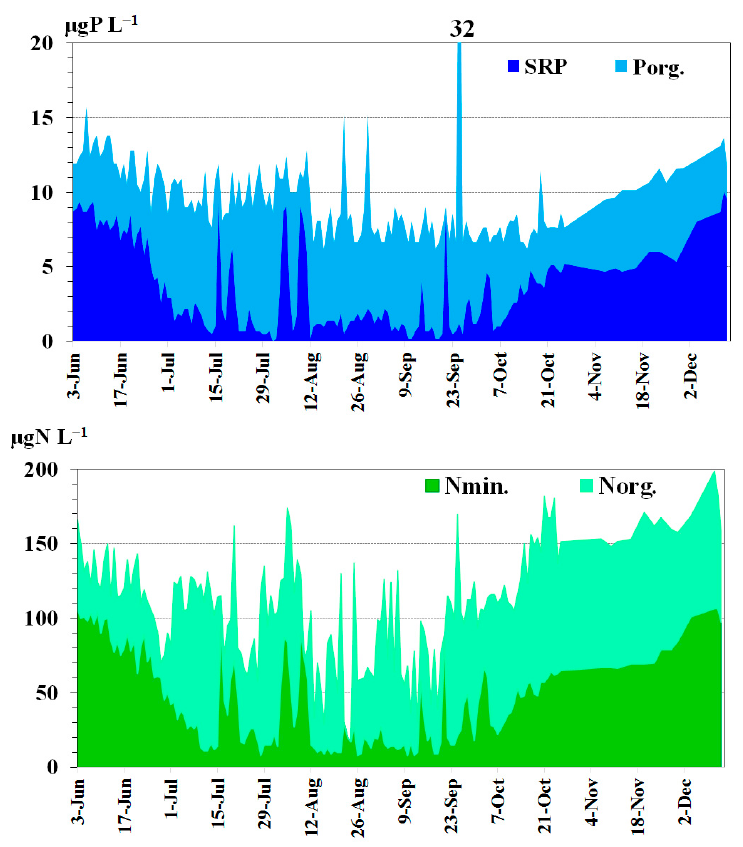
Figure 4. Concentrations of mineral and organic forms of nitrogen and phosphorus in the littoral zone of Lake Baikal in 2020.